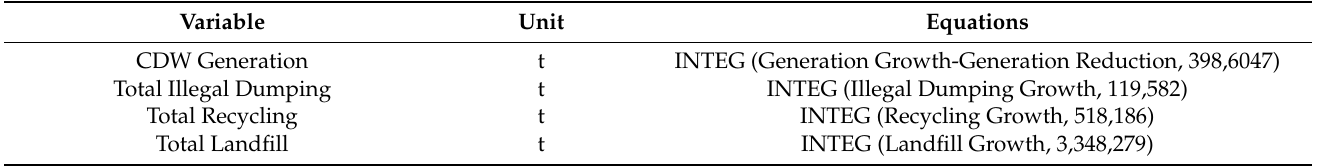
Table A6. Value of stock in the